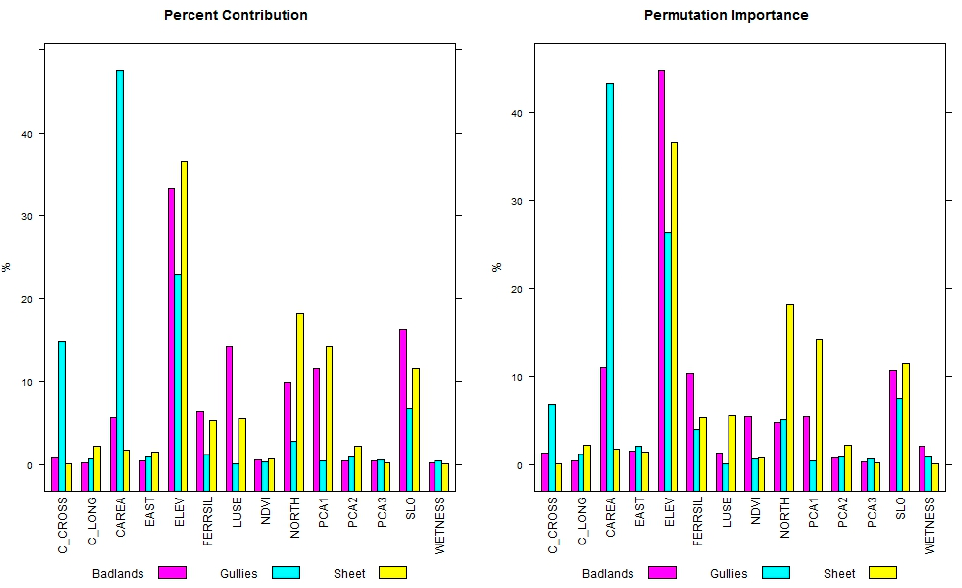
Figure 4. Variable importance for the three models. Geosciences 2020 , 10 , 248